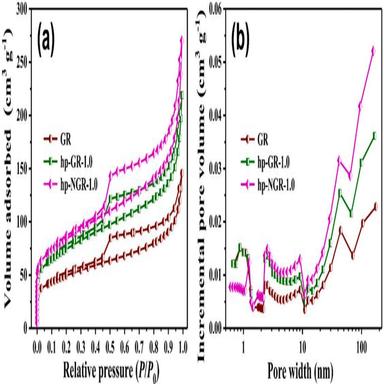
N2 adsorption-desorption isotherms (a) and pore diameter distribution curves (b) of GR and hp-NGR-1.0.